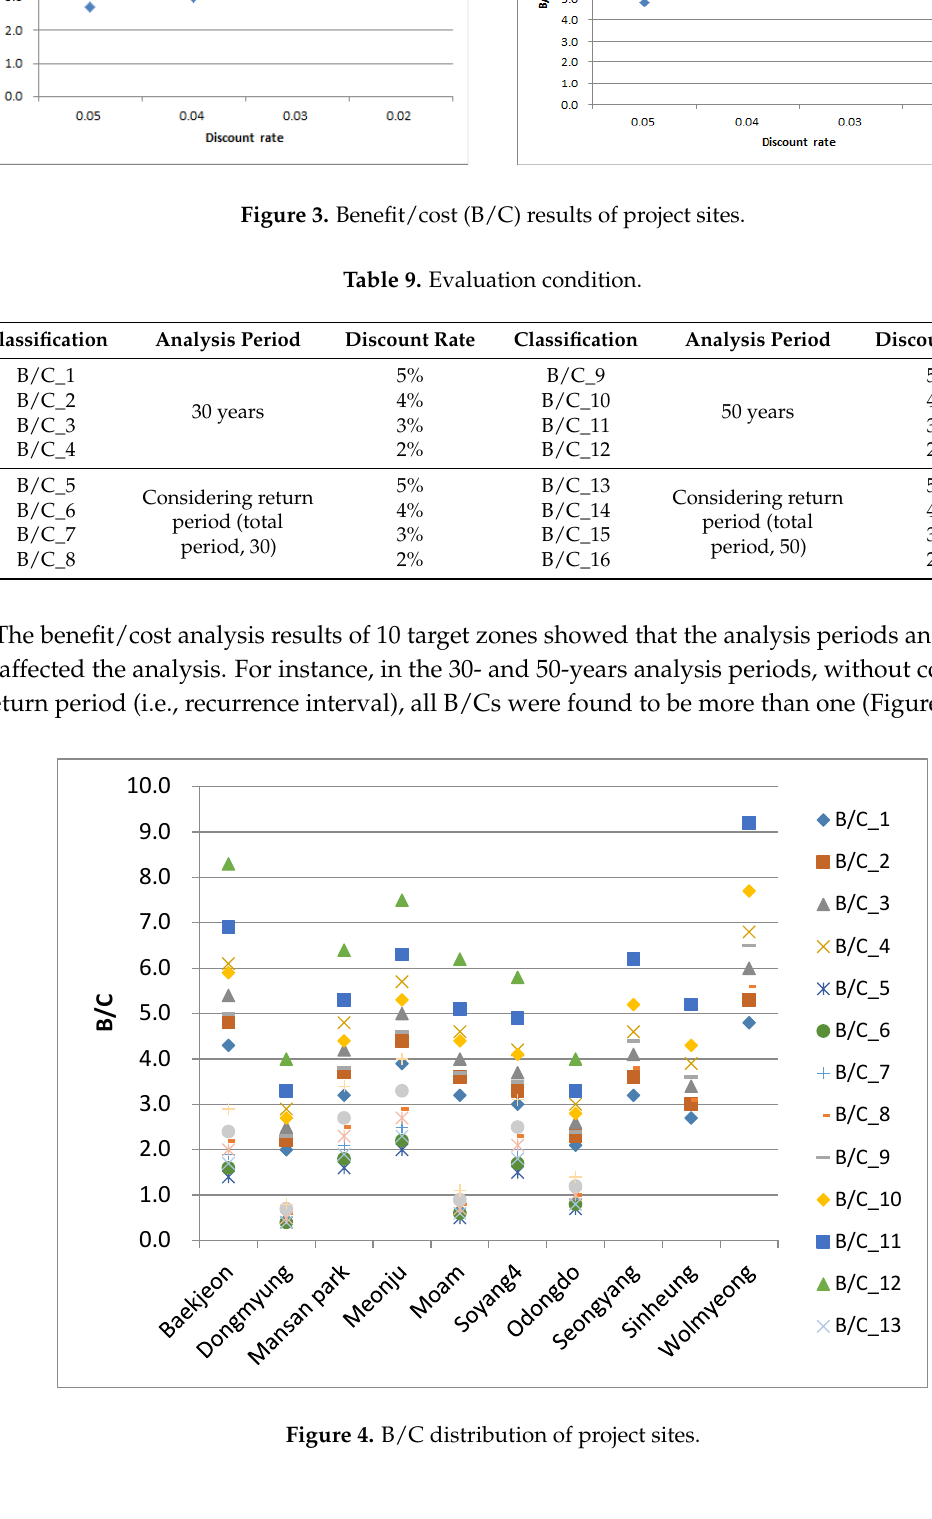
Figure 4. B/C distribution of project sites.